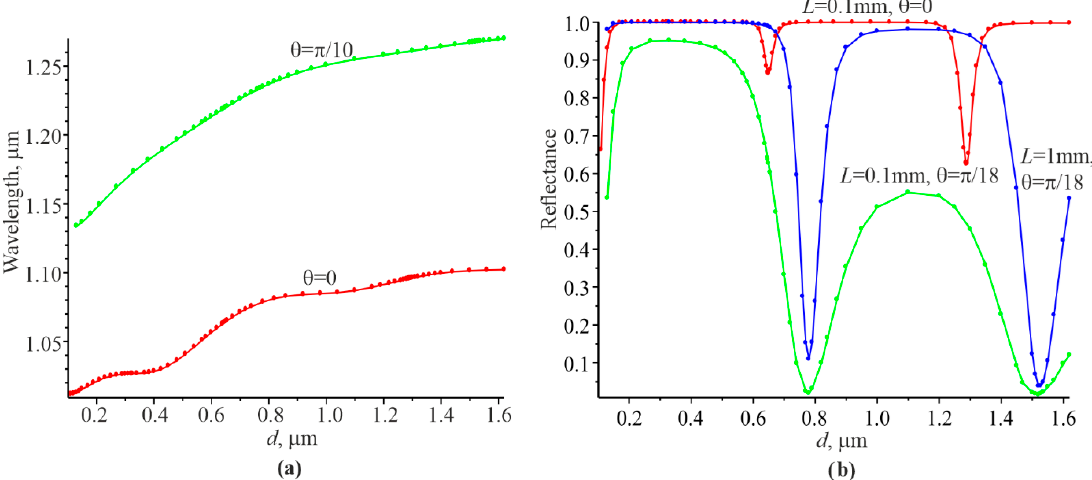
Figure 2. Dependences of the resonant wavelength on the grating thickness for the plane wave ( a ). Dependence of the relative reflectance P r on the grating for the Gaussian beam ( b ). L is the half-width of the Gaussian beam in accordance with Figure 1. The distribution of the Gaussian beam per 1001 plane wave (reprinted with permission from Ref. [40]) was used for numerical calculations. Each grating thickness 𝑑 has its own resonant wavelength 𝜆 (cid:3045)(cid:3032)(cid:3053) at which the reflec-